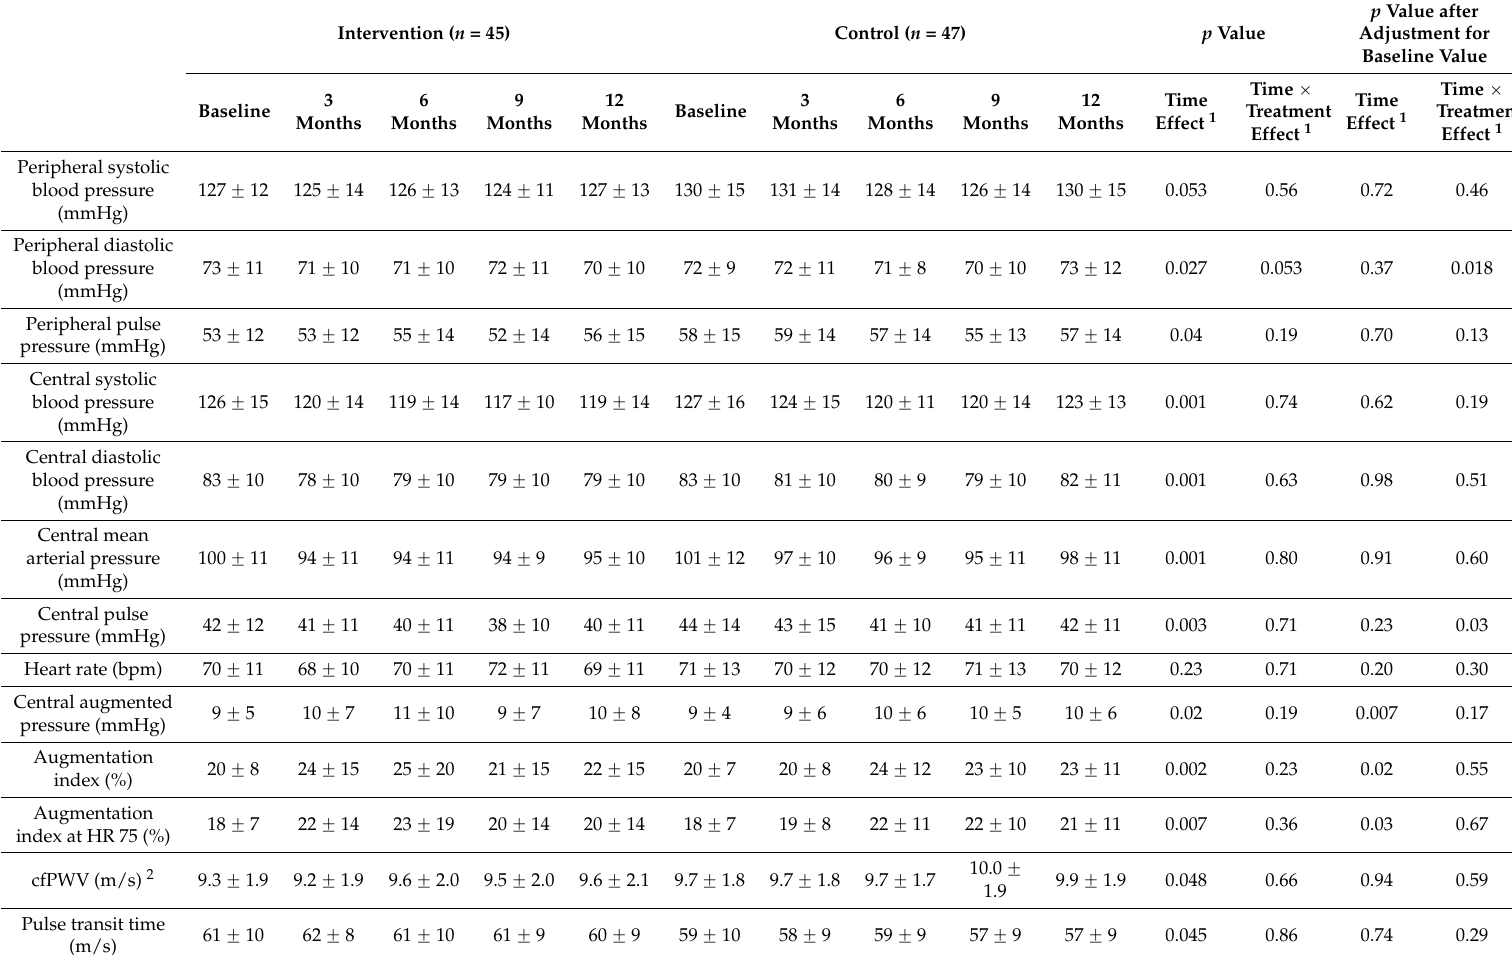
Table 2. Peripheral and central blood pressure (BP), augmentation index (AIx) and pulse wave velocity (cfPWV) by treatment group over the 12 months study